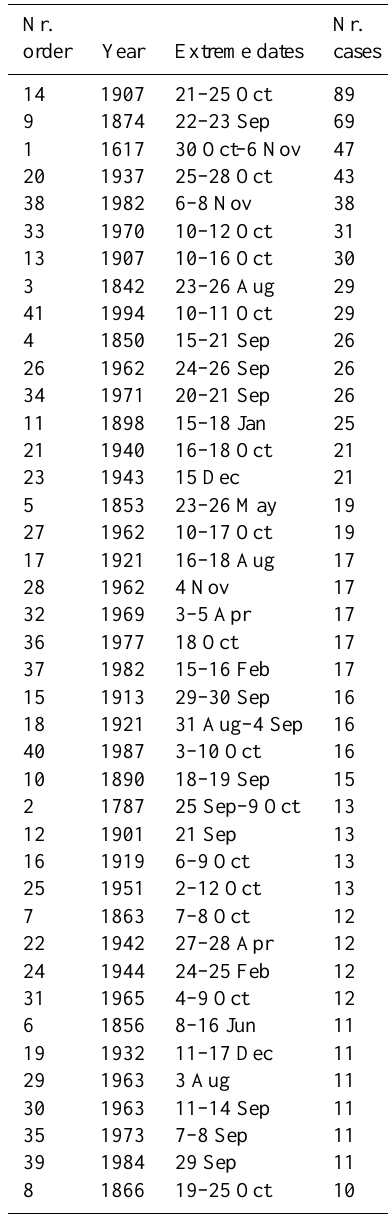
Table 3. Relation of flood events selected according to severity (10 or more cases per event). Sorted by number of documented